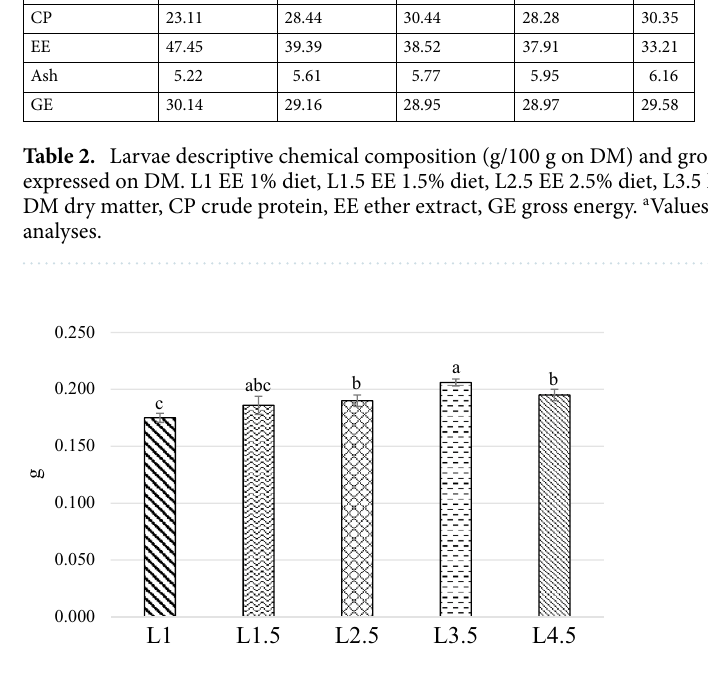
Figure 2. Diet effect on the prepupae weight. L1 EE 1% diet, L1.5 EE 1.5% diet, L2.5 EE 2.5% diet, L3.5 EE 3.5% diet, L4.5 EE 4.5% diet, GA Gainesville diet. Means with different superscript letters (a, b, c) within the same row differ significantly ( p < 0.05). The standard error is represented by the error bars.